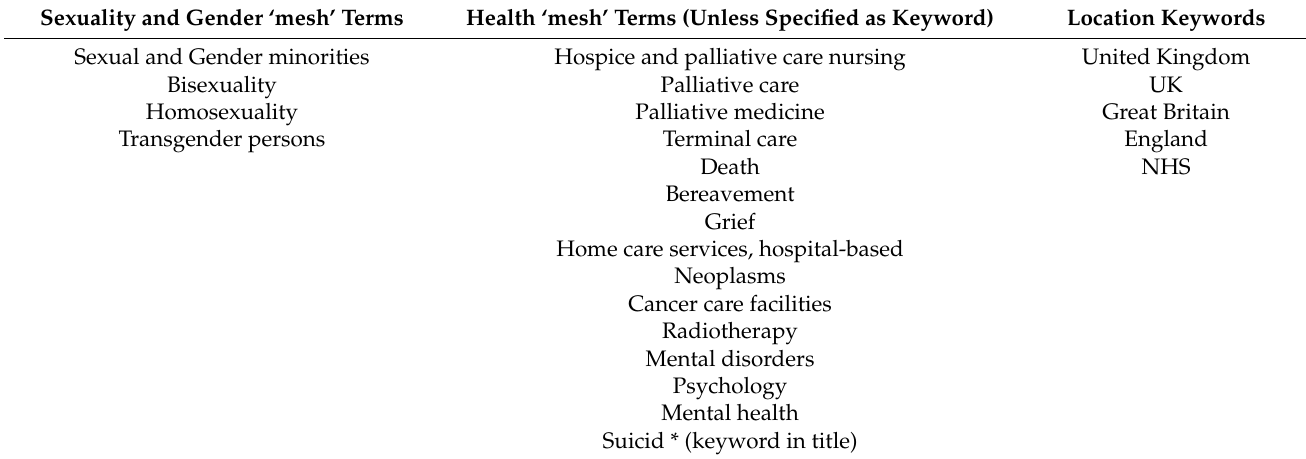
Table 2. PubMed search